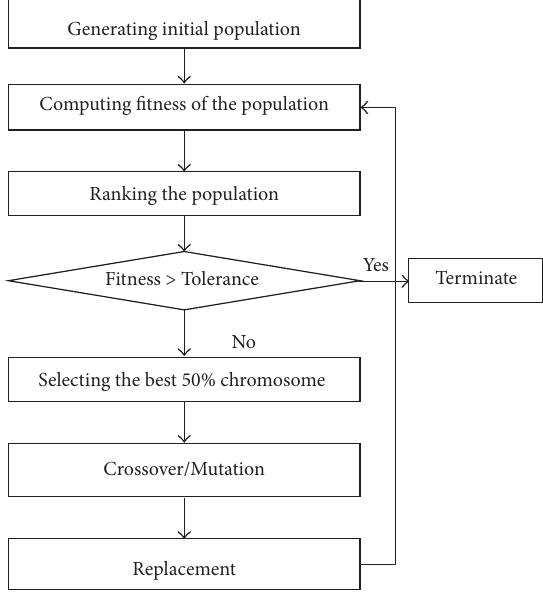
Figure 2: Flow chart of the GA-ARMA